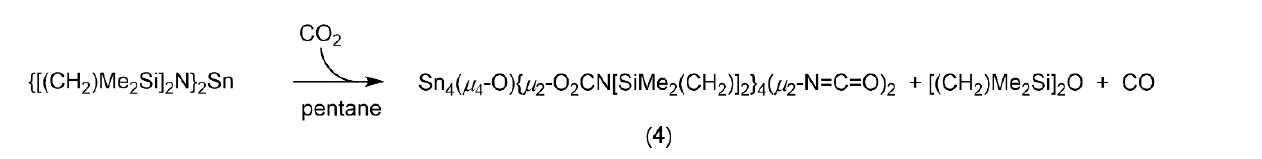
Scheme 13. Reaction scheme leading to Compound 4 , data from